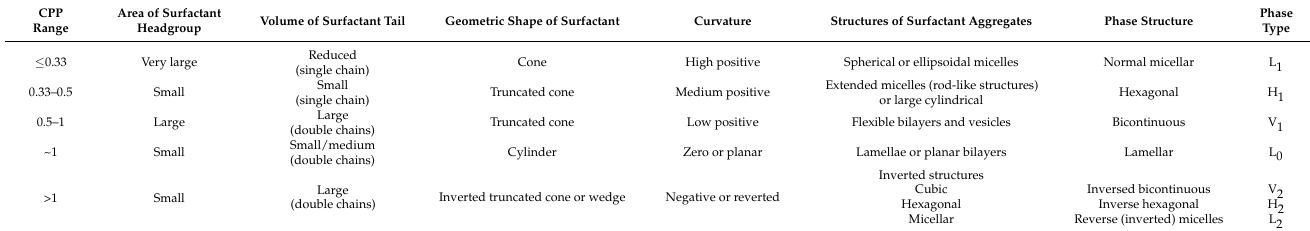
Table 1. Relationship between the molecular structure and characteristics of the surfactant and the corresponding phase type. CPP, critical packing parameter.